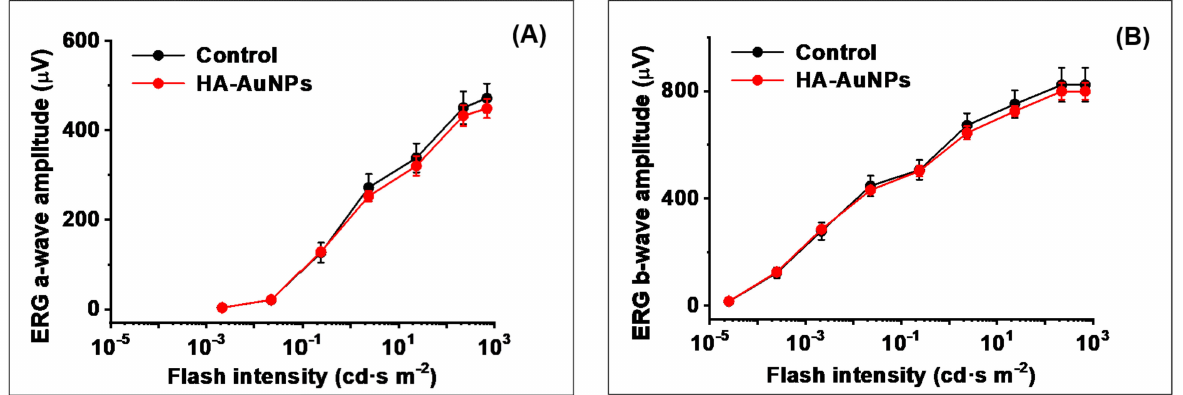
Figure 4. Topical application of HA-AuNPs does not affect scotopic ERG a-wave ( A ) and b-wave ( B ) responses of mice in vivo. Averaged rod intensity-response functions (mean ± SEM, p > 0.05 for all data points) for control PBD-treated wild-type mouse left eyes ( n = 4) and right eyes of the same animals treated with HA-AuNPs ( n = 4). Recordings were performed 1 h after